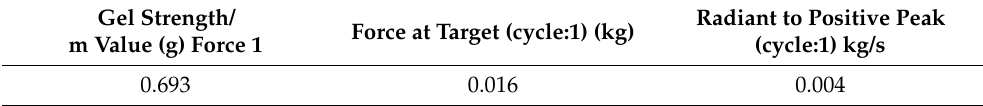
Table 8. Test data of gel strength.